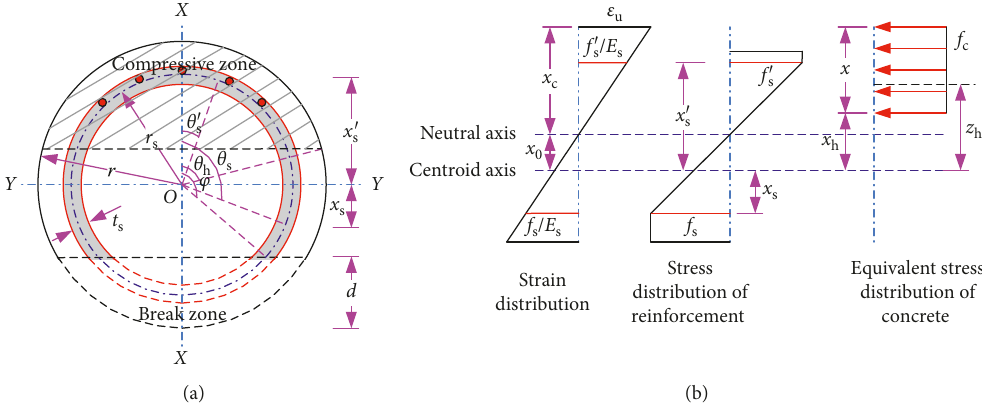
Figure 5: Calculation diagram of flexural strength of normal section with pile body partial